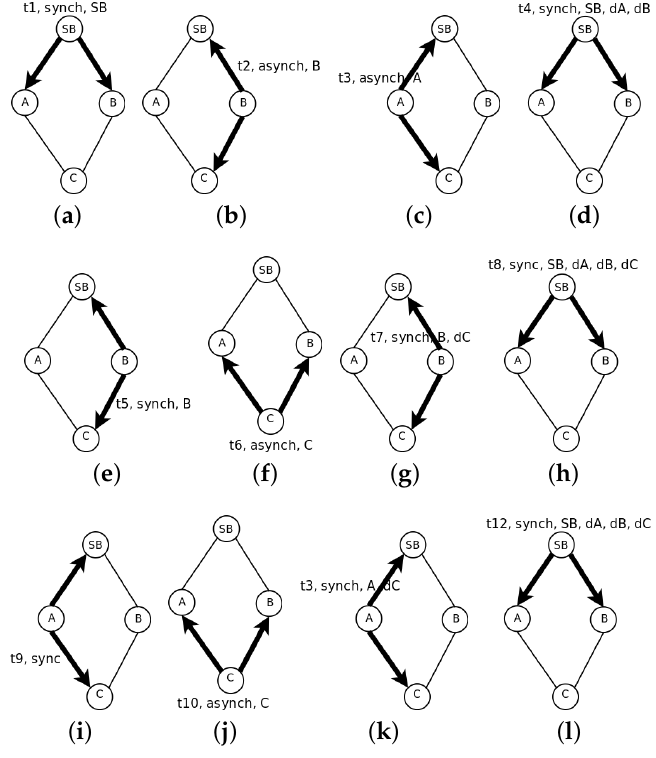
Figure 2. Example of the synchronization process: ( a – l